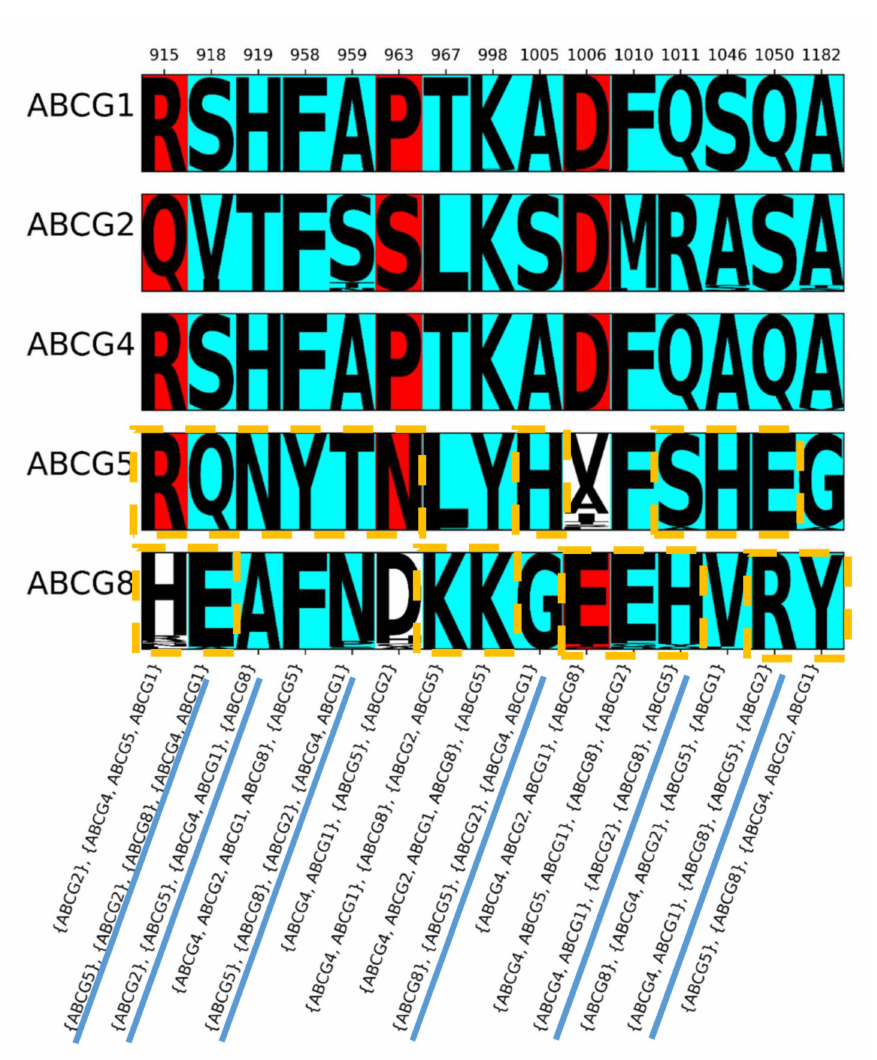
Figure 4. Conservation patterns in columns corresponding to the polar relay in ABCG5/G8. Columns coloured as in Figure 2. Orange dashed boxes indicate the polar relay for ABCG5 and ABCG8. Columns with the conservation pattern (ABCG1, ABCG4), (ABCG2), (ABCG5), (ABCG8) have that pattern underlined in blue at the